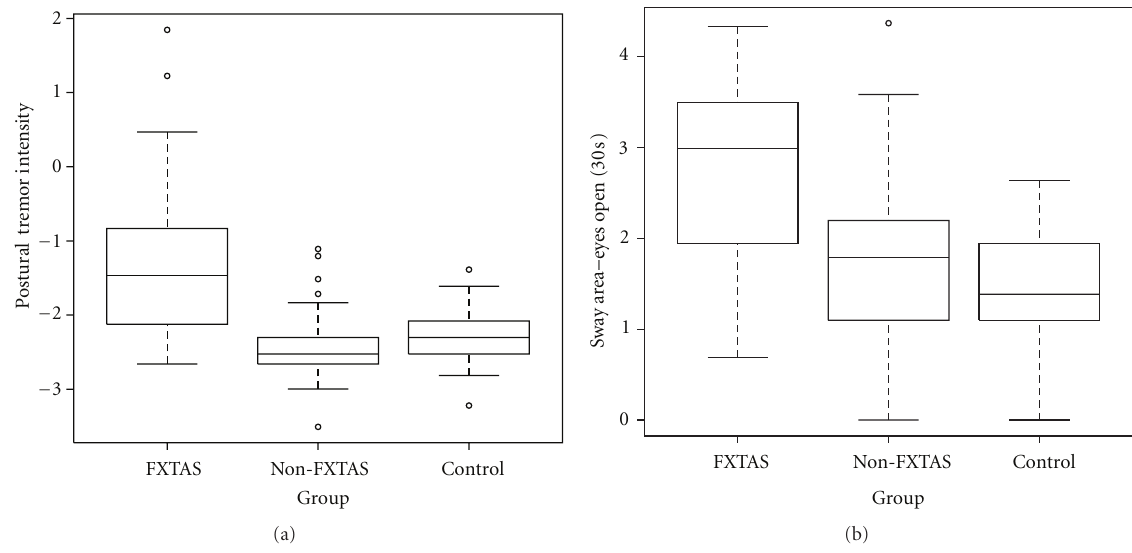
Figure 1: (a) Distribution/boxplots of (log) sway area (mm 2 ) for eyes open 30sec. task. Sway area was significantly higher in patients with FXTAS, compared to controls ( P < . 0001), as well as non-FXTAS ( P < . 0001). (Note: results una ff ected by an outlying observation.) (Interior box horizontal bar = median). (b) Distribution/boxplots of (log) postural tremor intensity (m/sec 2 ) in dominant hand (similar results for nondominant hand). Postural tremor intensity was significantly higher in patients with FXTAS, compared to controls ( P < . 0001), as well as non-FXTAS ( P < . 0001). (Note: results una ff ected by outlying observations.) (Interior box horizontal bar = median).